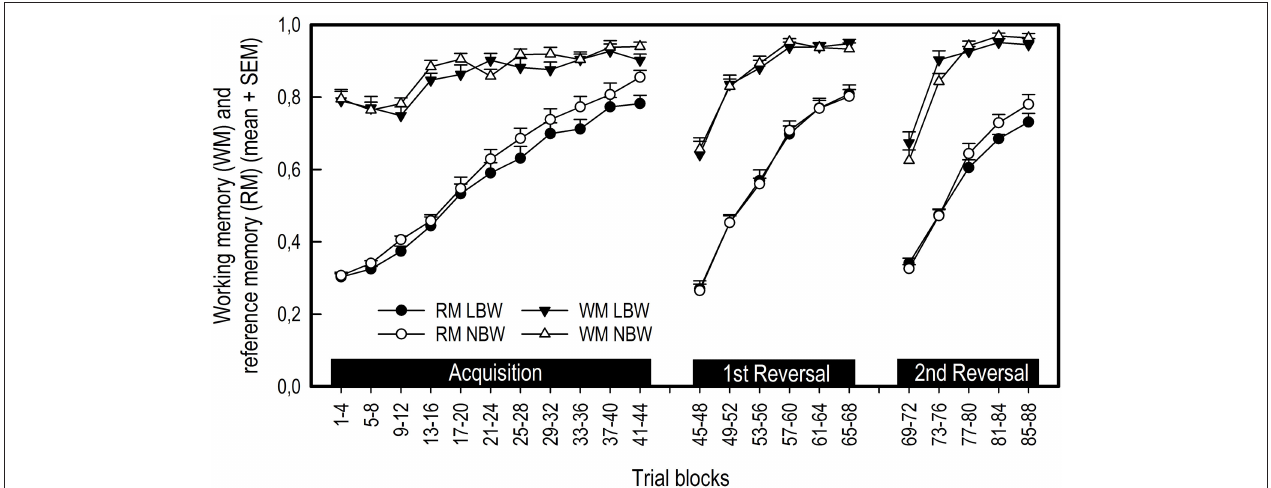
FIGURE 3 | Average working memory (WM) and reference memory (RM) scores of LBW and NBW pigs in the spatial holeboard task per trial block. There was no significant effect of sex on holeboard performance, either as a main effect or interaction with birth weight. Therefore, the data for males and females have been